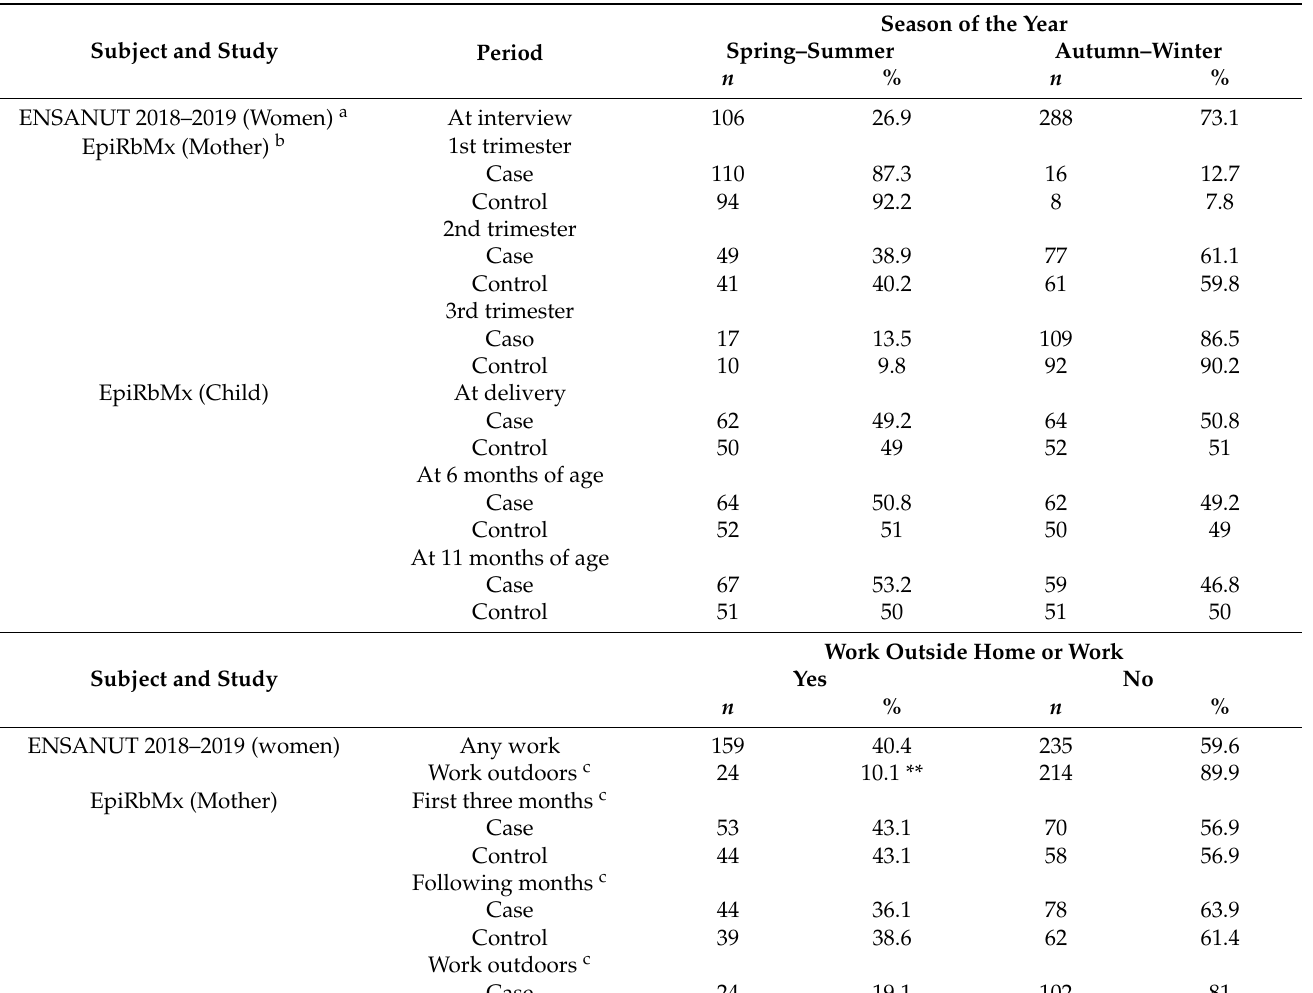
Table 2. Distribution of children and women by season of the year and type of work ENSANUT 2018–2019 and